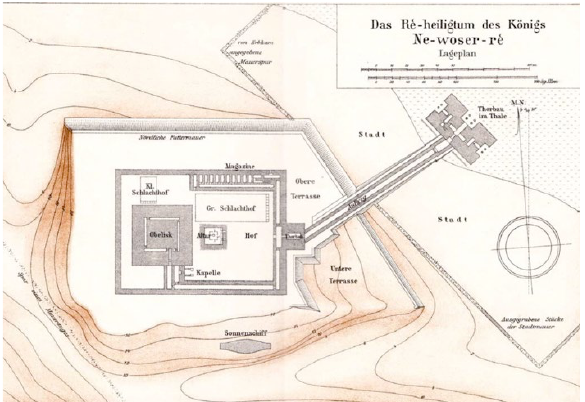
Figure 1: The Sun Temple of Niuserra. General map (Borchardt 1905).